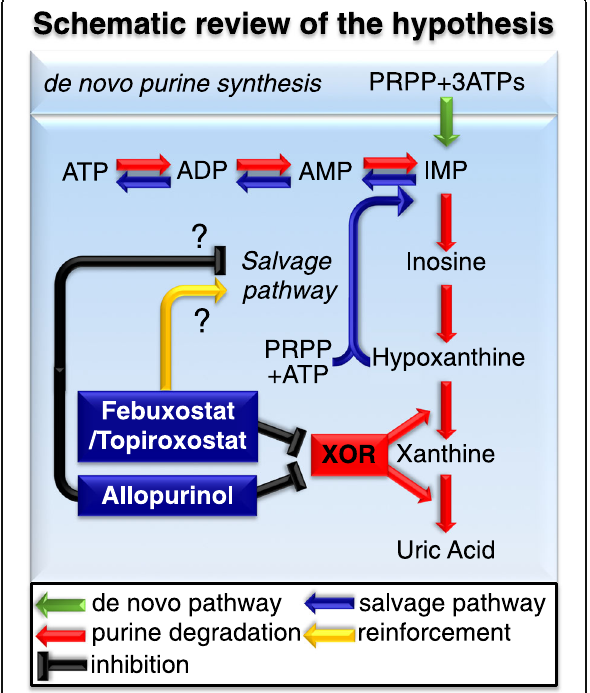
Fig. 6 Schematic review of the hypothesis. When an organ is exposed to anaerobic condition, high-energy phosphates are degraded, and accumulation of xanthine and uric acid are usually greater than hypoxanthine in tissues through conversion of hypoxanthine to xanthine, and xanthine to uric acid by XDH activity. After reperfusion, these purine metabolites are washed out from tissues without XOR inhibition. Meanwhile, administration of non- purine-XOR inhibitors induce hypoxanthine accumulation in tissues by inhibiting XDH. After reperfusion, this excessive hypoxanthine is converted to IMP by hypoxanthine-guanine phosphoribosyltransferase (HGPRTase), a salvage pathway enzyme, which will be utilized for ATP resynthesis, and thus contribute to better energetic outcomes. As allopurinol itself act as a substrate for HGPRTase consuming PRPP, administration of allopurinol may inhibit ATP resynthesis via the salvage pathway. PRPP, phosphoribosyl diphosphate; ATP, adenosine triphosphate; ADP, adenosine diphosphate; AMP, adenosine 5 ′ -monophosphate; IMP, inosine monophosphate; XOR, xanthine